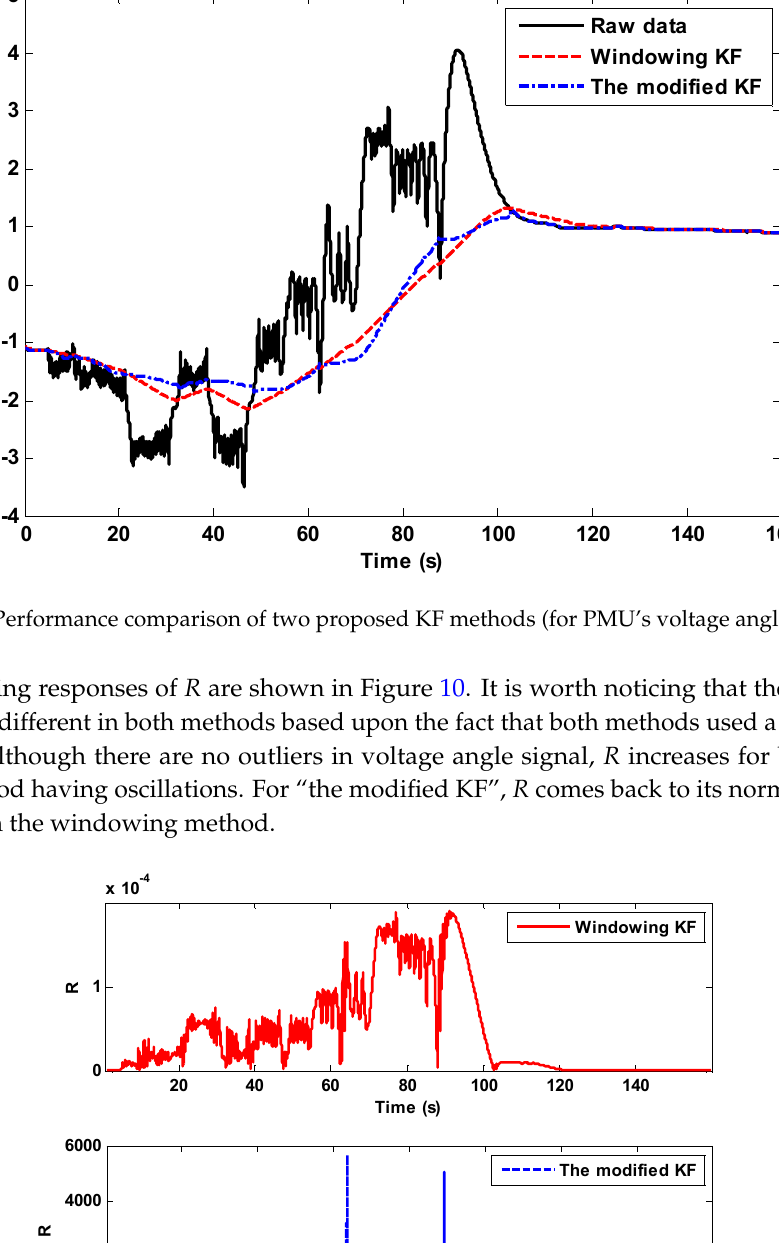
Figure 8. Comparison for updating R for proposed KF methods (for voltage magnitude signal).